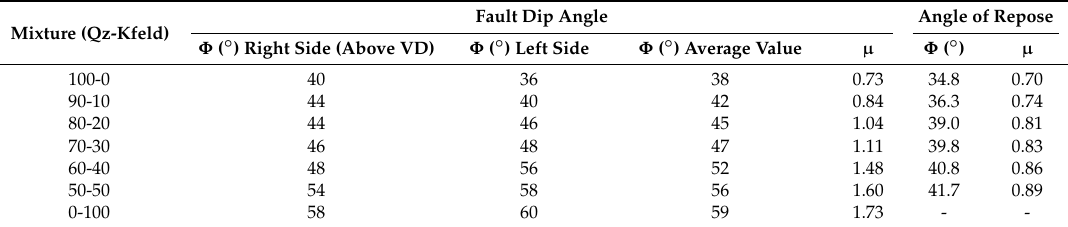
Table 3. Summary table of the angles and coefficients of internal friction of the different granular mixtures measured with the two different empirical methods (fault dip angle and fixed base cone; see text for details).